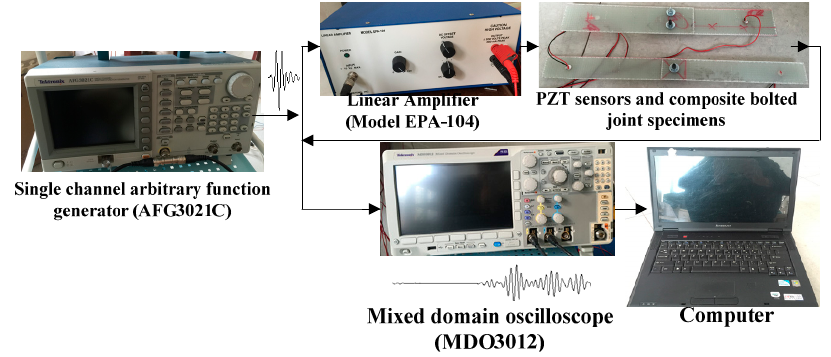
Figure 3. Experimental setup of the Lamb wave-based Structural health monitoring (SHM) system.